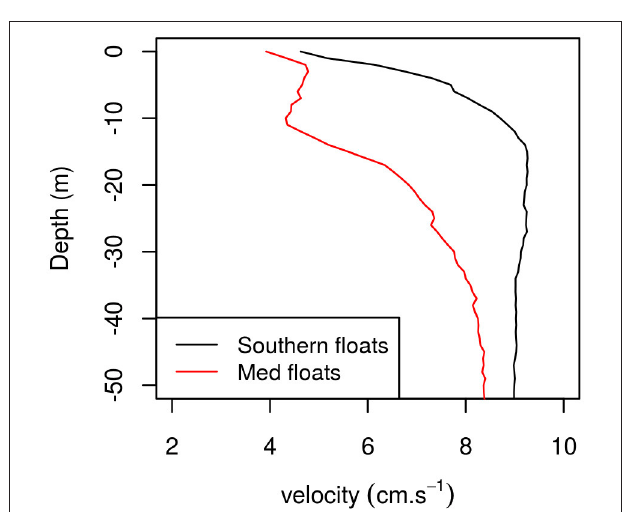
FIGURE 6 | Median profile of ascent velocity for the Mediterranean Sea (red) and Southern Ocean (black) floats. Only shallowest 50m are shown as velocity at depth is